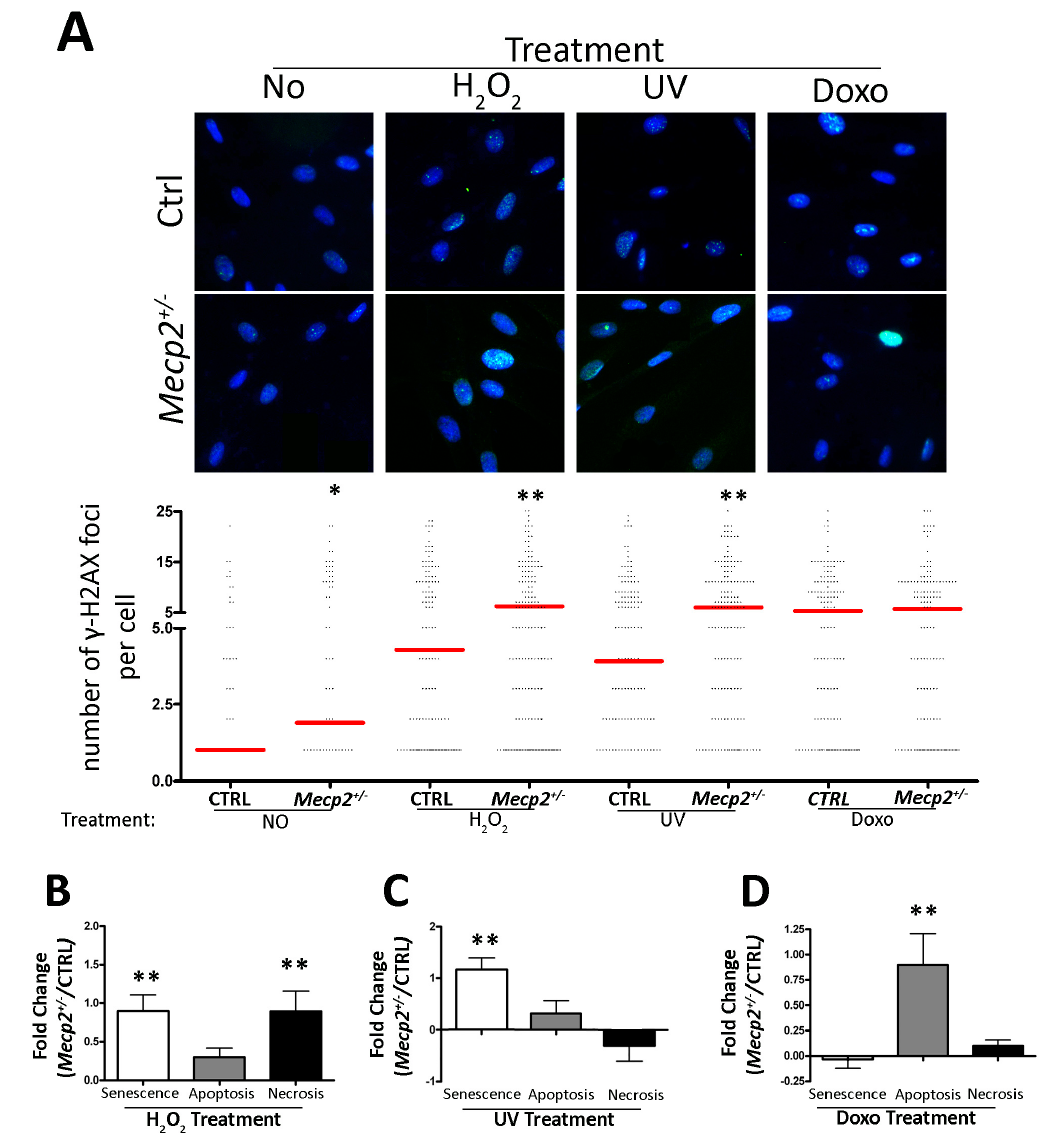
Figure 2. DNA damage, senescence, apoptosis, and necrosis. ( A ) Representative microscopic fields showing the merging of the Mecp2 +/ − and CTRL MSCs stained with anti- γ -H2AX (green) and 4 ′ ,6-diamidino-2-phenylindole (DAPI) (blue). The column scatter plot indicates the degree of H2AX phosphorylation that was determined by counting the number of γ -H2AX immunofluorescent foci per cell. The foci number was determined for 200 cells. Each dot represents a single cell. The horizontal bars indicate the mean value for each category ( Mecp2 +/ − and CTRL MSCs; n = 5 biological replicates; * p < 0.05; ** p < 0.01). ( B – D ) The DNA damage levels 48 h following genotoxic treatments with hydrogen peroxide (H 2 O 2 ), UV irradiation, and doxorubicin, respectively. For every condition, the degree of DNA damage was determined by counting γ -H2AX foci. Changes in the level of senescence, apoptosis, and necrosis in the Mecp2 +/ − MSCs were compared with the CTRL cells 48 h post DNA damage treatment. Senescence was analyzed by the 4-methylumbelliferyl- β - d galactopyranoside (MUG) quantitative fluorescent assay. 4-MUG is a β -galactosidase substrate that emits fluorescence only when it is cleaved by the enzyme to generate fluorophore 4-methylumbelliferone. The fluorophore production was monitored at an emission / excitation wavelength of 365 / 460 nm. Apoptosis was detected with the fluorescein conjugated Annexin V Kit and apoptotic cells were identified with a fluorescence microscope. Necrotic cells were detected by using Trypan blue staining. Non-viable cells were identified with an inverted microscope. The data are expressed in fold change ( ± SD, n = 5 biological replicates; * p < 0.05, ** p < 0.01).